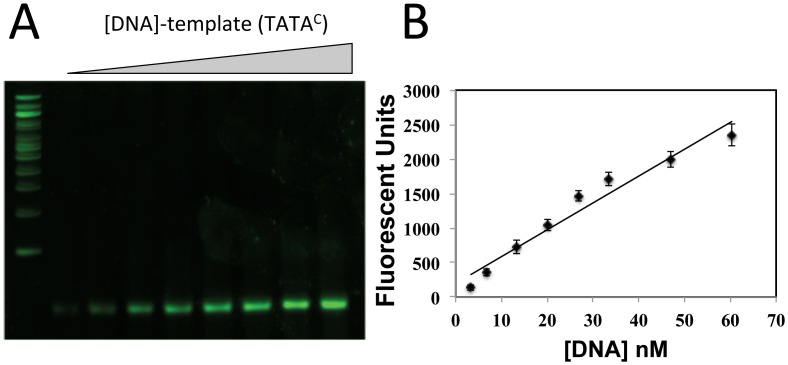
Sensitivity of nucleic acid stain.(A) Increasing concentrations of TATAC-oligonucleotide (0, 3.35, 6.7, 13.4, 20.1, 26.8, 33.5, 46.9, and 60.3 nM) were resolved on 6% non-denaturing SDS-PAGE and analyzed as detailed in the Experimental procedures section. (B) Quantification of fluorescent signal from panel (A). Linear fit: y = 38.94x + 196.3; R² = 0.95782.